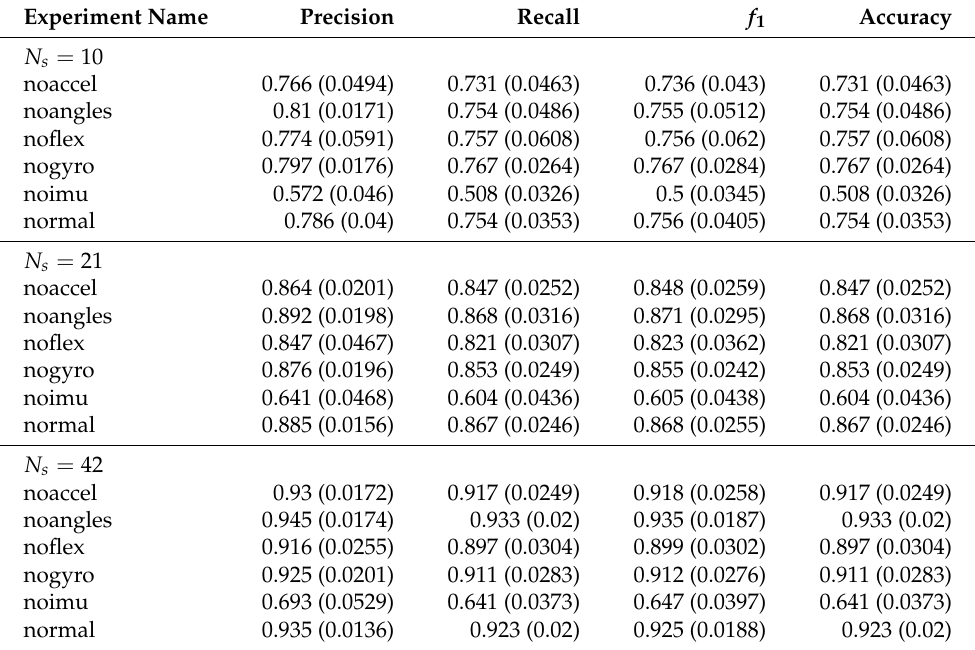
Table A5. Five-fold cross validation results for type of exercise